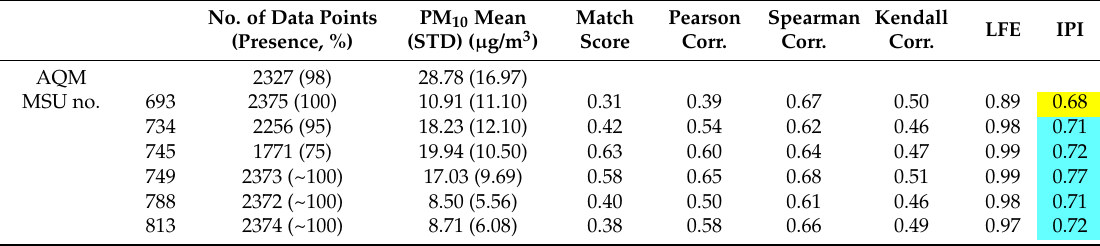
Table 7. Selected SET results for PM 10 measurements in Ostrava (CZ). Sampling period: 1 June to 7 September 2015, sampling rate: 1 h, color code as in Table